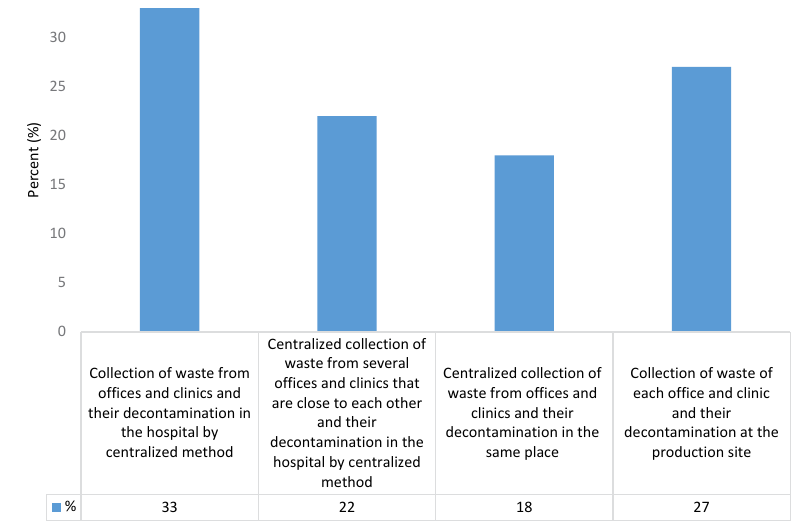
Figure 1. Prioritization of the method of collection and disposal of decentralized health care waste in terms of